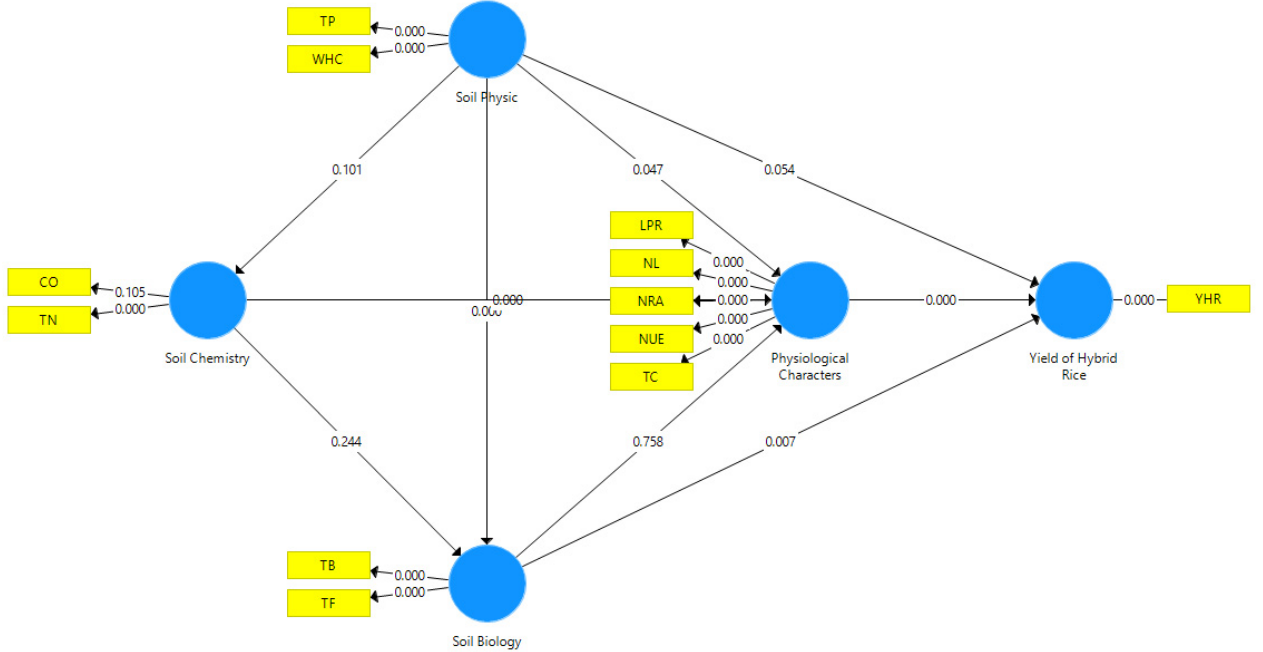
Figure 5. Relationship between soil properties (physic, chemistry, biology), physiological traits, and yield of hybrid rice.